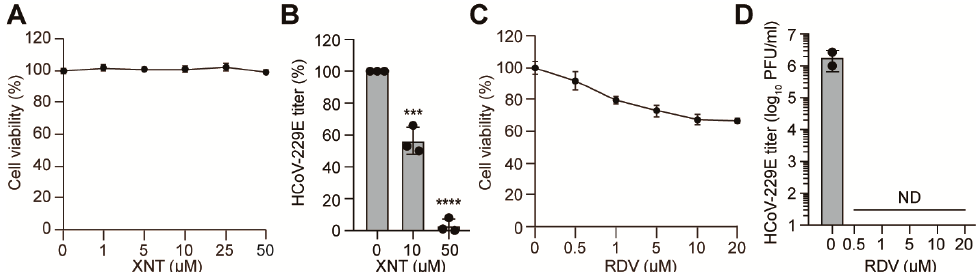
Figure 4. Comparison of antiviral activity of XNT and RDV against a common-cold-causing HCoV-229E. ( A , C ) Cytotoxicity of XNT ( A ) and RDV ( C ) in Huh7 cells, measured by MTS assay 48 h after treatment with increasing concentrations of the compounds. Data are mean ± SD from four biological repeats. ( B , D ) Infectious virus titers, determined 48 h after treatment of HCoV-229E-infected Huh7 cells (MOI = 0.0001) with XNT or RDV. ND, not detected. Bar graphs show the mean ± SD from biological replicates. In ( A , B ), the vehicle includes a final concentration of 0.1% DMSO. ( C , D ) Vehicle, 0.4% DMSO. RDV in each concentration has a final concentration of 0.4% DMSO. *** p < 0.001; **** p < 0.0001; by unpaired two-tailed Student’s t -test.